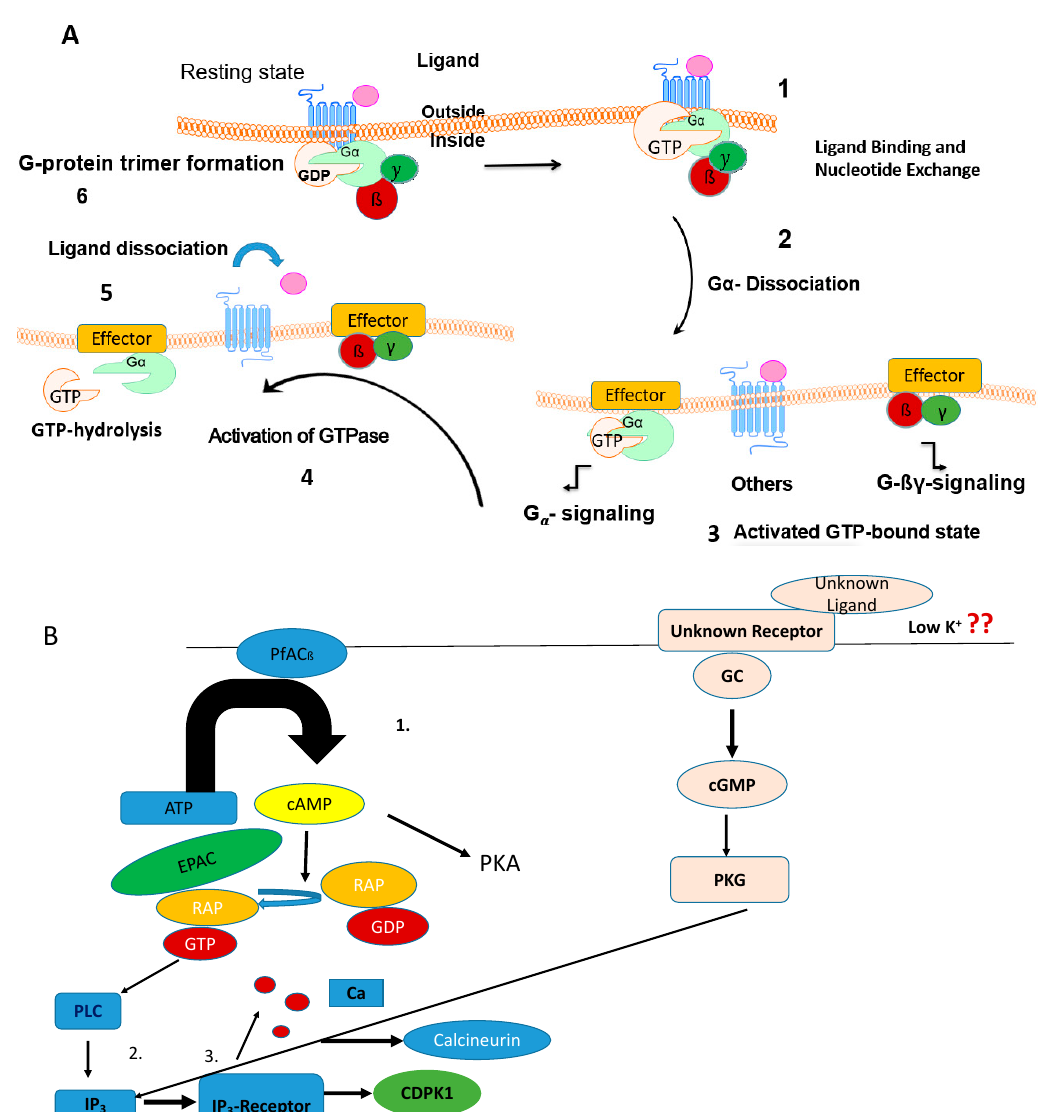
Figure 1. Comparison of a canonical, cAMP-signaling pathway in the human host cell and in Apicomplexan parasites: ( A ) Activation/reactivation cycle of a heterotrimeric G-protein in the context of G-protein-coupled receptor (GPCR) signaling: 1. binding of a ligand to the receptor causing a conformational change, 2. GDP bound to the alpha-subunit is exchanged to GTP, 3. dissociation of the alpha-subunit from the G βγ -dimer and the receptor, 4. Formation of a complex between the G-alpha subunit or the G βγ -dimer and the effector molecule 5. Activation of a GTPase that hydrolyzes GTP to GDP under the control of a regulator of G-protein signaling, 6. Trimer formation of the different G-protein subunits. ( B ) Non-canonical cyclic nucleotide signaling pathways in Plasmodium . The exchange protein (EPAC) pathway (left side of the figure): 1. during egress and invasion of merozoites PfAC β triggers cAMP levels fostering the EPAC pathway which in turn leads to phosphorylation of Rap-GDP to Rap-GTP. 2. Rap-GTP activates phospholipase C (PLC) to produce inositol triphosphte (IP 3 ) that binds to the IP 3 receptor. 3. Activation of the IP 3 receptor leads to a release of calcium ions. Calcium ions bind to calcineurin and activate calcium-dependent protein kinase 1 (CDPK1). Middle part of the figure: besides the EPAC pathway cAMP activates protein kinase A. Right part of the figure: at low potassium concentrations an unknown ligand binds to the SR25 receptor which mediates the signal to a guanylyl cyclase that activates protein kinase G. Protein kinase G (PKG) acts in concert with a stage specific calcium dependent kinase.